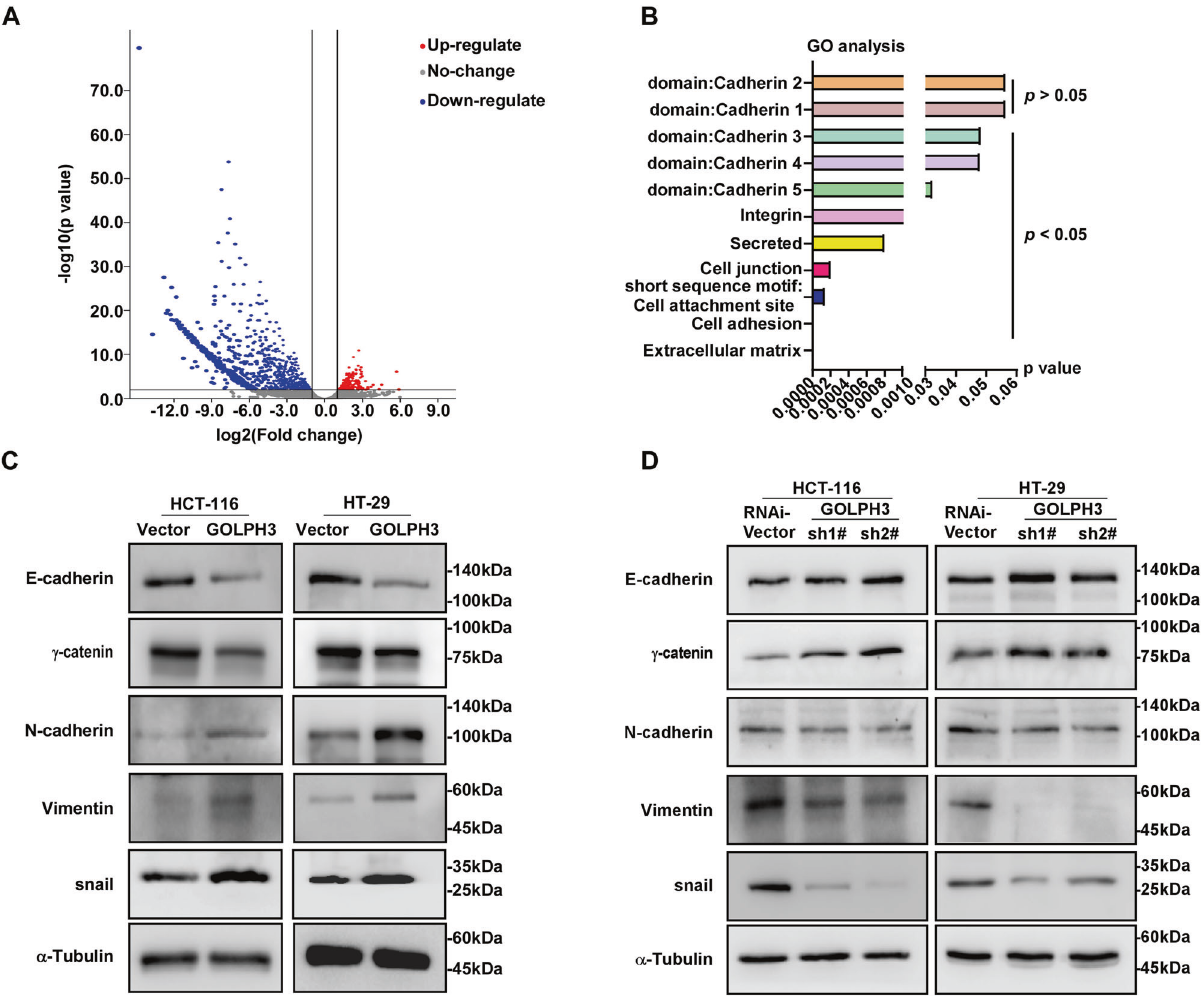
Fig. 4 GOLPH3 overexpression promotes colon cancer metastasis by enhancing EMT. A A volcano plot showing RNA-seq-detected gene expression in HCT-116-PMSCE-Vector and HCT-116-PMSCV-GOLPH3 cells. Differentially expressed genes were fi ltered using a P -value < 0.05 as a threshold. Red spots represent upregulated genes, green spots represent downregulated genes, and blue spots represent genes that showed no obvious change. B Differentially expressed genes between HCT-116-PMSCV-Vector and HCT-116-PMSCV-GOLPH3 cells assessed using GO analysis. C Western blotting analysis of EMT-related markers in GOLPH3 -overexpressing cells and their controls; α -Tubulin was used as an internal reference. In GOLPH3 -overexpressing cells, epithelial markers (E-cadherin, γ -catenin) were downregulated, while mesenchymal markers (N-cadherin, vimentin, and Snail) were upregulated. D The opposite results to those obtained in C were observed when GOLPH3 was